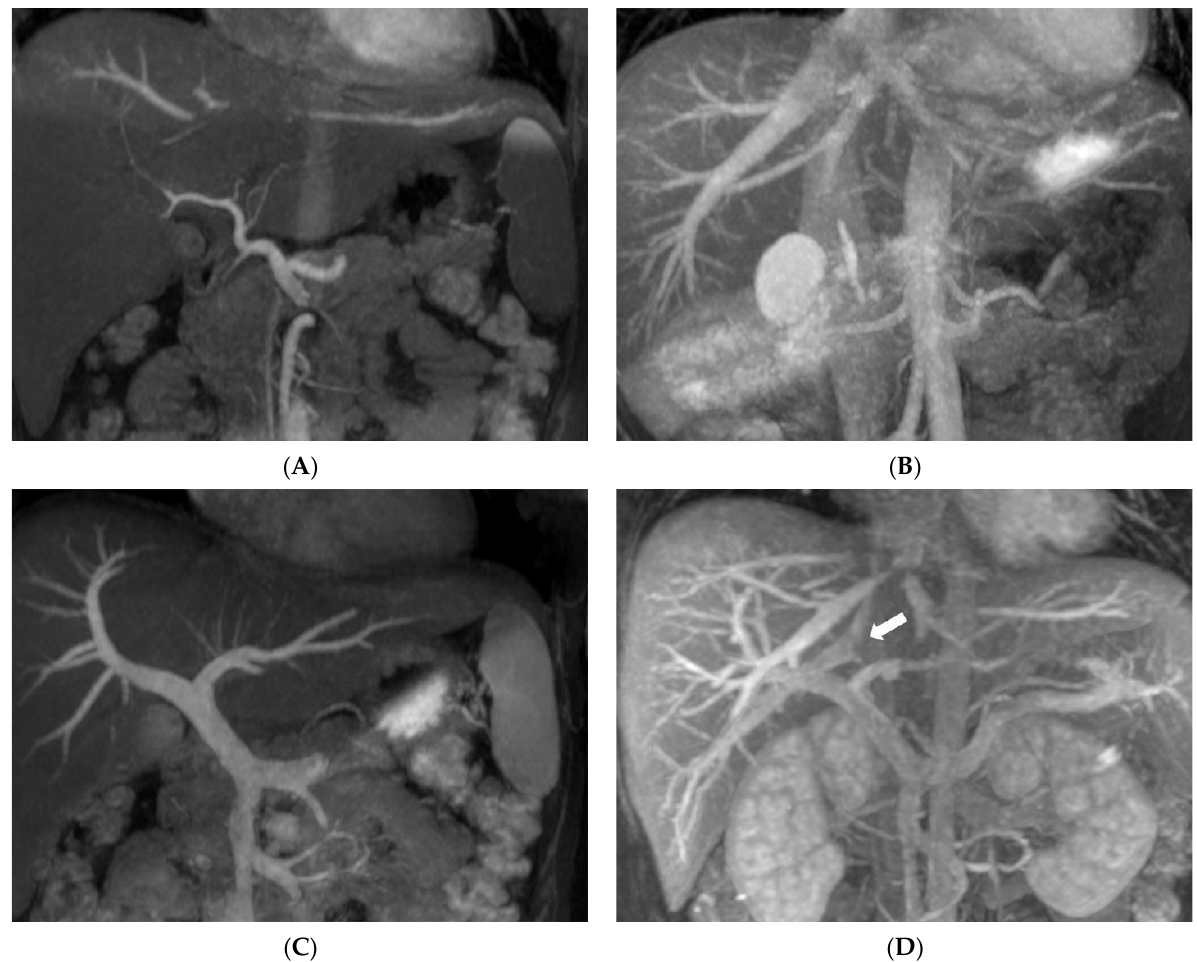
Figure 2. Selective visualization of hepatic vasculature in non-CE MRA compared with CMRA: ( A ) Selective depiction of hepatic artery of a 24-year-old female donor. Partial hepatic vein signal in the superior part of the liver due to non-saturated region, but without obscuring hepatic artery. ( B ) Clear depiction of hepatic veins of a 32-year-old male donor without portal vein overlapping; high signal of gallbladder was also depicted but does not interfere with the interpretation of hepatic veins. ( C ) A 24-year-old female donor’s portal veins are also clearly depicted. ( D ) CMRA of hepatic veins in the same donor as in ( C ), with portal vein overlapping and one IRHV (white arrow) crossing over the right portal vein.